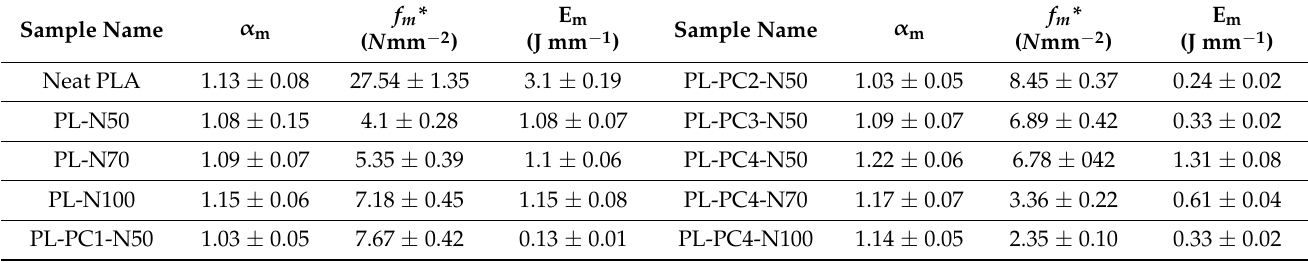
Table 3. Maximum elongation, nominal force and maximum energy of the various films.